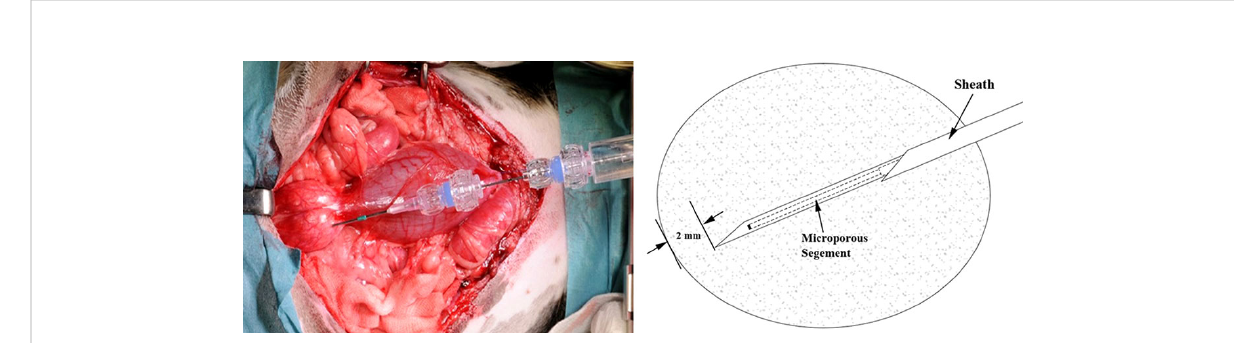
FIGURE 2 Left. Intraoperative image of the porous needle attached to the fi xation apparatus and deployed into the left lobe of the prostate. Right. Schematic drawing showing the sharp tip of the protective sheath with the porous segment of the needle inside it. After the proper position of the needle is achieved, sheet is retracted to expose the porous